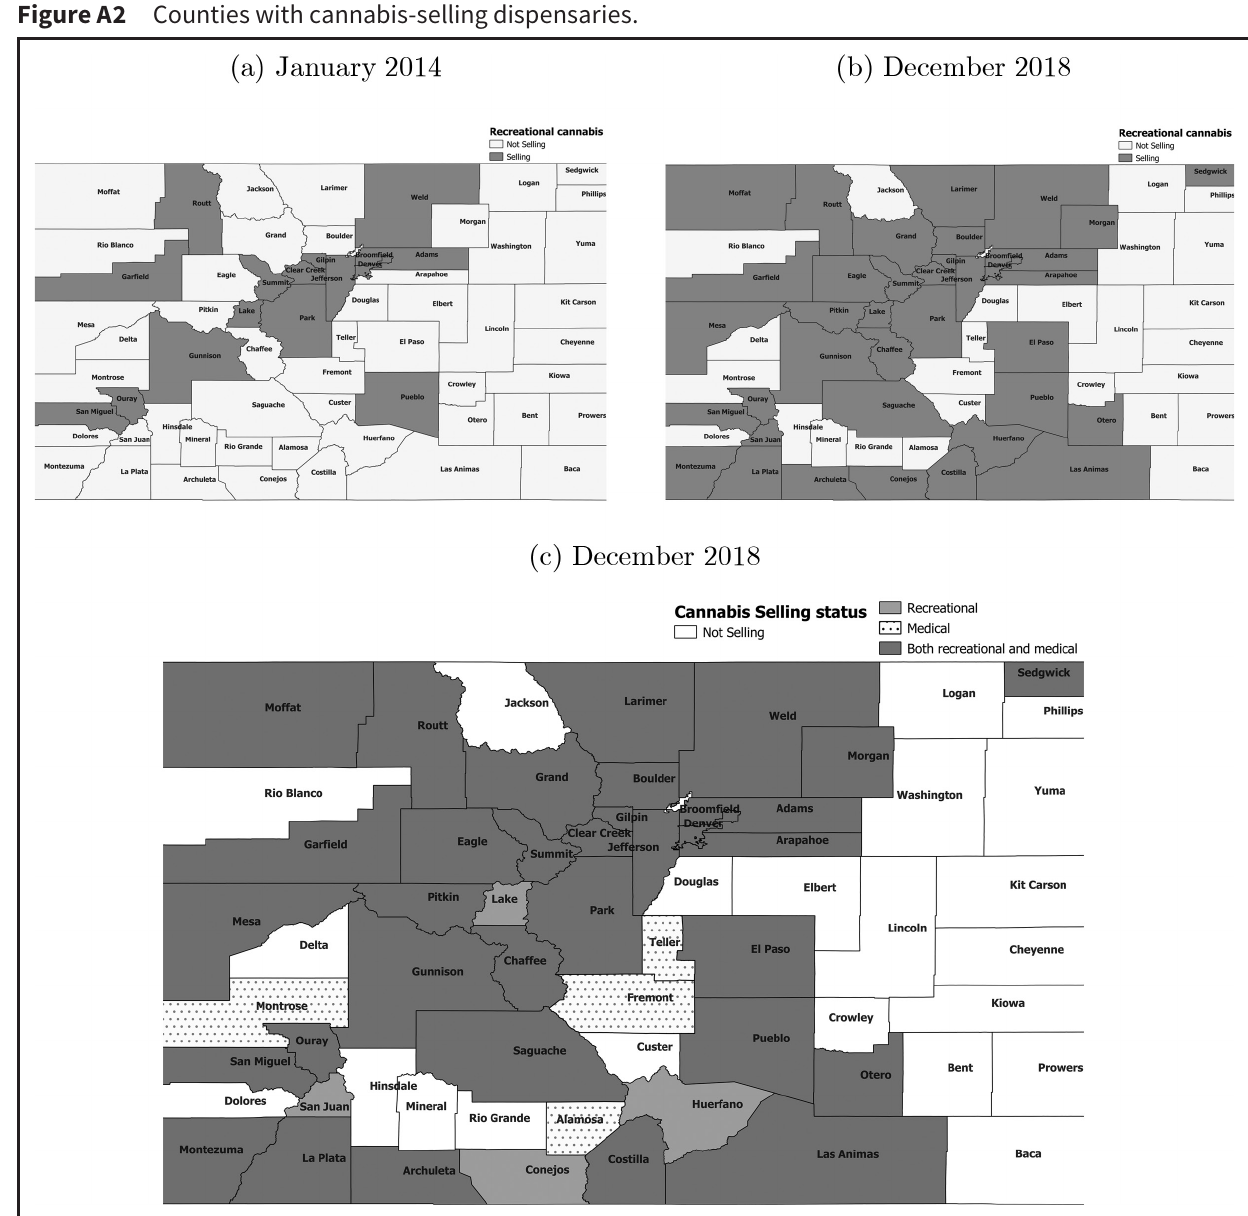
Counties with cannabis-selling